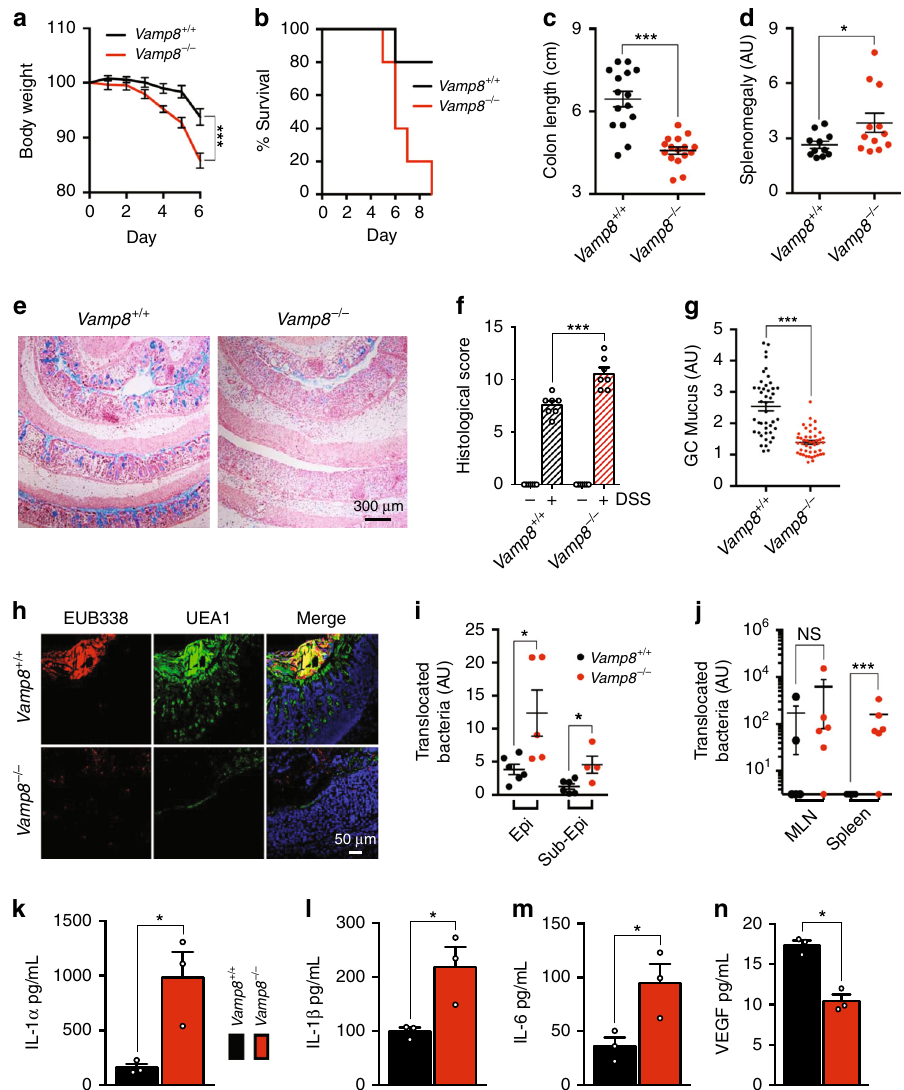
Fig. 6 Lack of Vamp8 exacerbates DSS-induced colitis. a Mice were treated with 2.5% DSS in the drinking water for 5 days and monitored daily for body weight loss (pooled from three independent experiments, >3 mice per group). b Survival following DSS treatment was tracked and animals losing more than 20% of initial body weight were sacri fi ced. Classical markers of DSS colitis at day 6 were measured including shortening of the colon c and splenomegaly d . e , f Histological examination and scoring f by Alcian blue staining at day 6 following DSS showed hallmarks of pathology including loss of goblet cell mucin, crypt architecture, edema, and thickening of the muscularis (three independent experiments, >3 mice per group, scale bar 300 μ m). g Goblet cell-associated mucus was quanti fi ed from alcian blue stained sections from multiple ROIs after 6 days of DSS (pooled from 9 mice per genotype, >5 ROIs analyzed per mouse by surface area). h Penetration and association of commensal bacteria with the epithelial cells following DSS was visualized by FISH staining with the bacterial probe EUB338 and mucin visualization with UEA1 (three independent experiments, three mice per group, scale bar 50 μ m). i Quanti fi cation of bacteria present in the epithelial cell layer and sub-epithelial cell layer was performed from confocal FISH images (representative data from one experiment repeated three individual times with more than three mice per group). j To measure bacterial translocation to extra intestinal sites, spleen and mesenteric lymph nodes were homogenized and tissue lysate grown overnight with enumeration of CFU from serial dilutions counted (representative data from one experiment repeated, two individual times with more than three mice per group). Key pro-in fl ammatory cytokines in colonic lysate, as well was factors involved in wound healing were assessed by multiplex bead assay including Il-1 α k , Il-1 β l , Il-6 m , and VEGF n (representative data from one experiment repeated two individual times with three mice per group). Bars indicate mean ± standard error of the mean. * P < 0.05, *** P